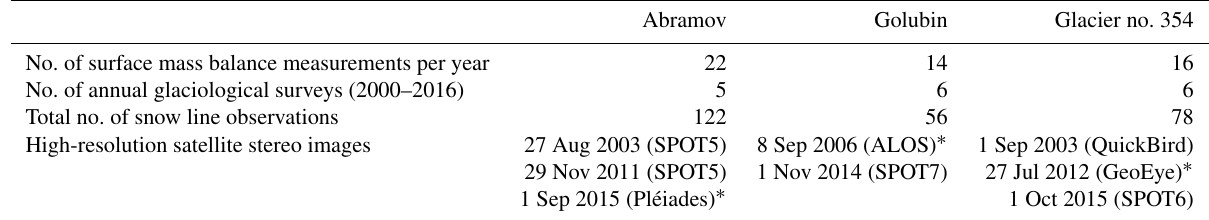
Table 1. Available data on glacier monitoring for the three glaciers used in this study. The dates marked with an asterisk indicate the DEMs used as a topographic base for the modelling.